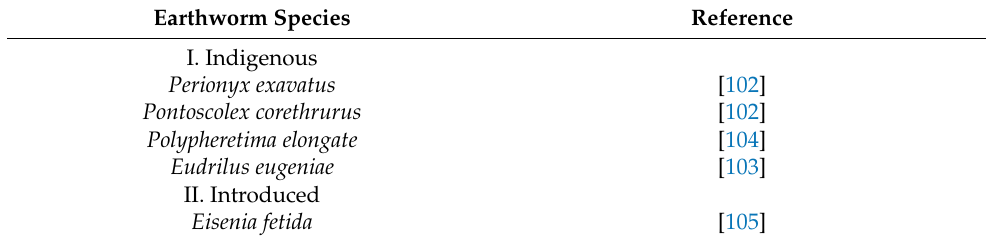
Table 3. Potential earthworm species for vermicomposting in South Pacific island